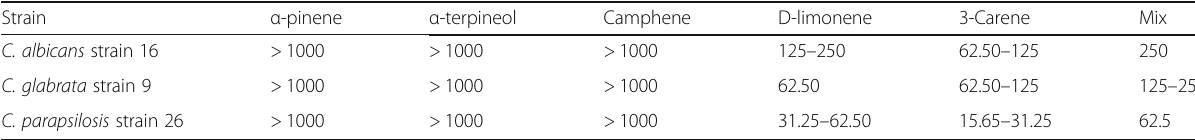
Table 3 MICs of pistachio hull EO pure compounds and their mix C. albicans strain 16, C. glabrata strain 9 and C. parapsilosis strain 26